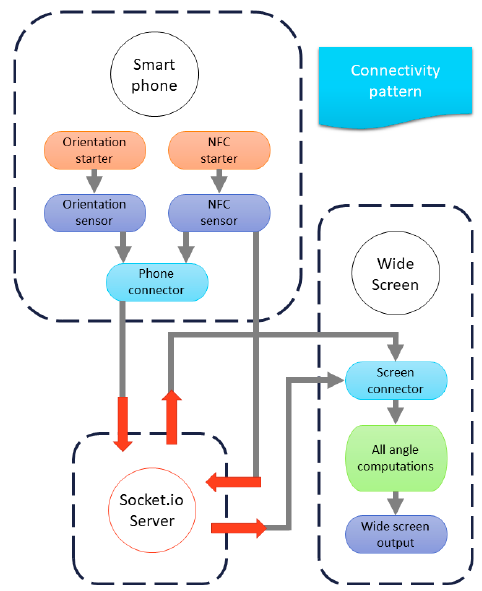
Figure 10. The connectivity pattern achieved with the help of the general node and an NFC scan event, which helps users connect one at a time to the MusExp application for interacting through their smartphone with the artifact displayed on the widescreen.